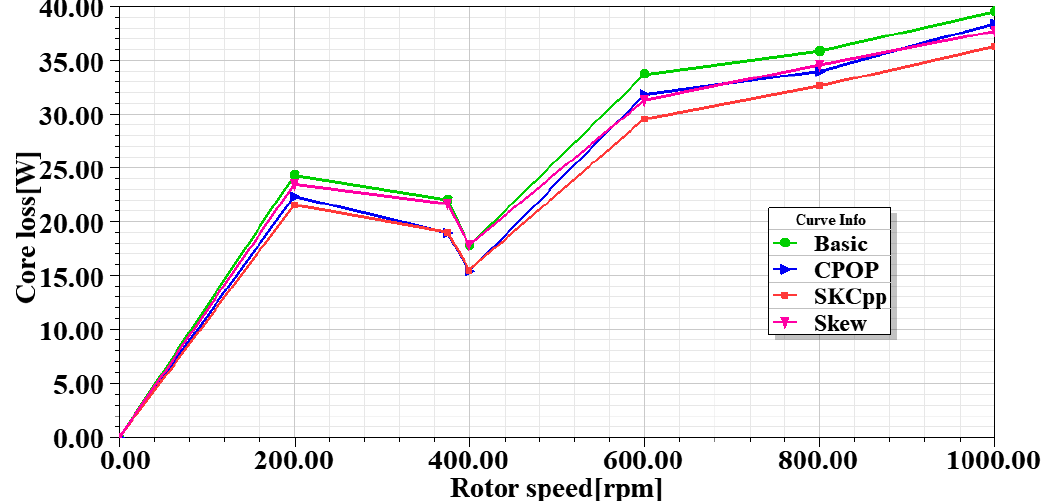
Figure 34. Core-loss against rotor mechanical speed (rpm) for each rotor design @ 375 r/min.